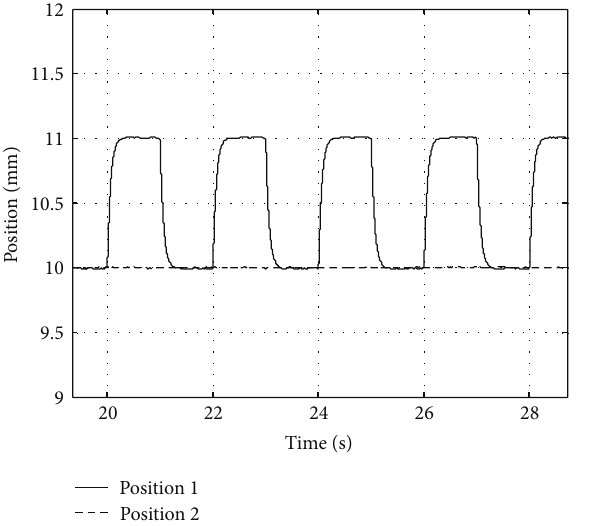
Figure 7: Position curves of algorithm